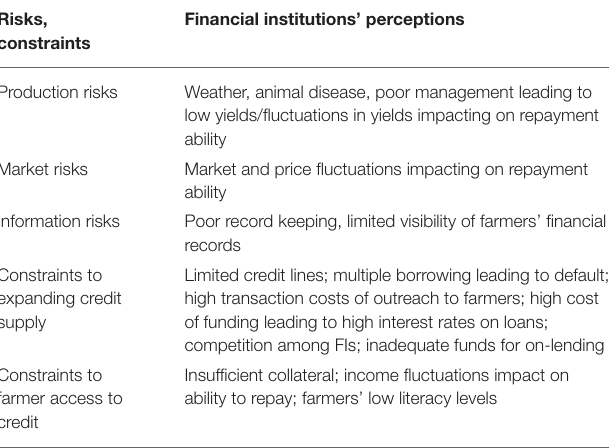
TABLE 5 | Risks and constraints to dairy sector lending as perceived by financial institutions. Risks,